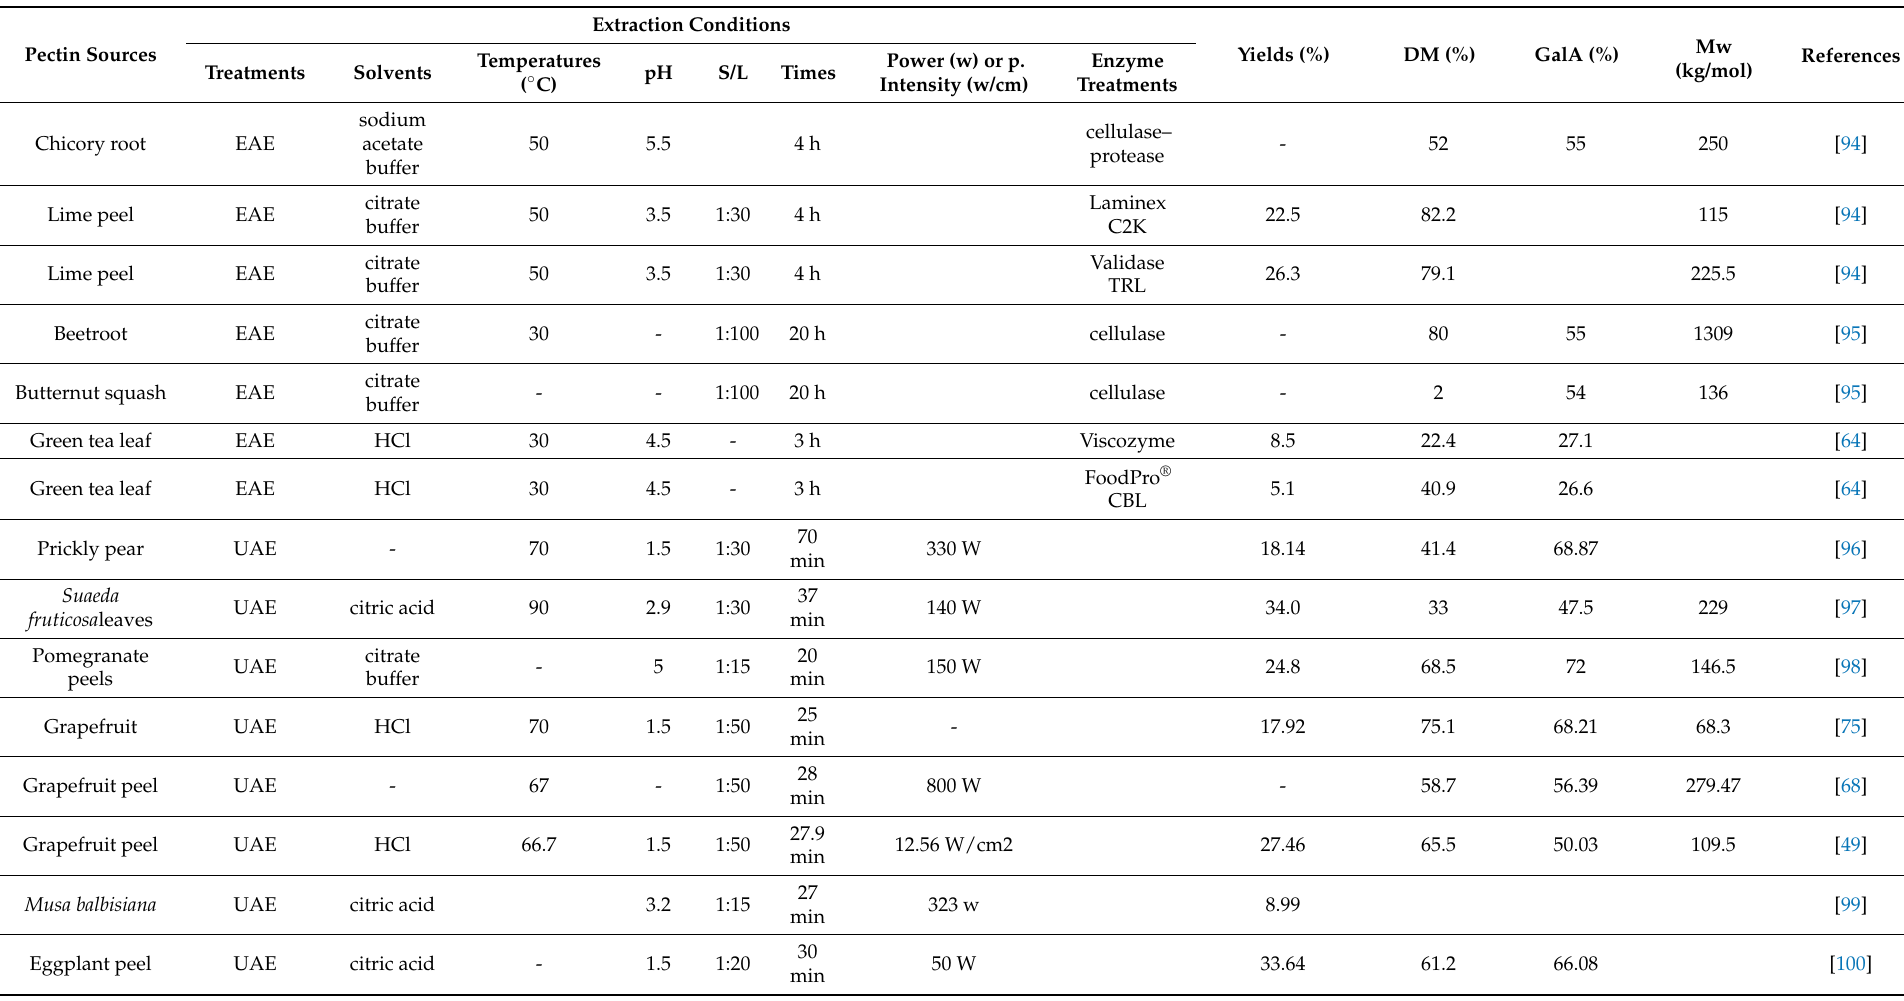
Table 2. Extraction conditions and physico-chemical properties of pectin extracted by green methods from agricultural wastes, food by-products, and others.